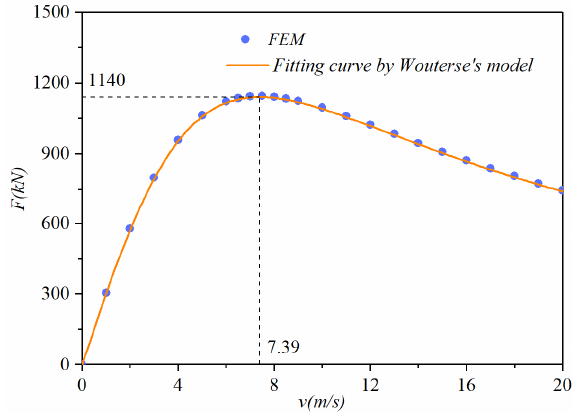
Figure 14. Force-velocity relationship of the design example.